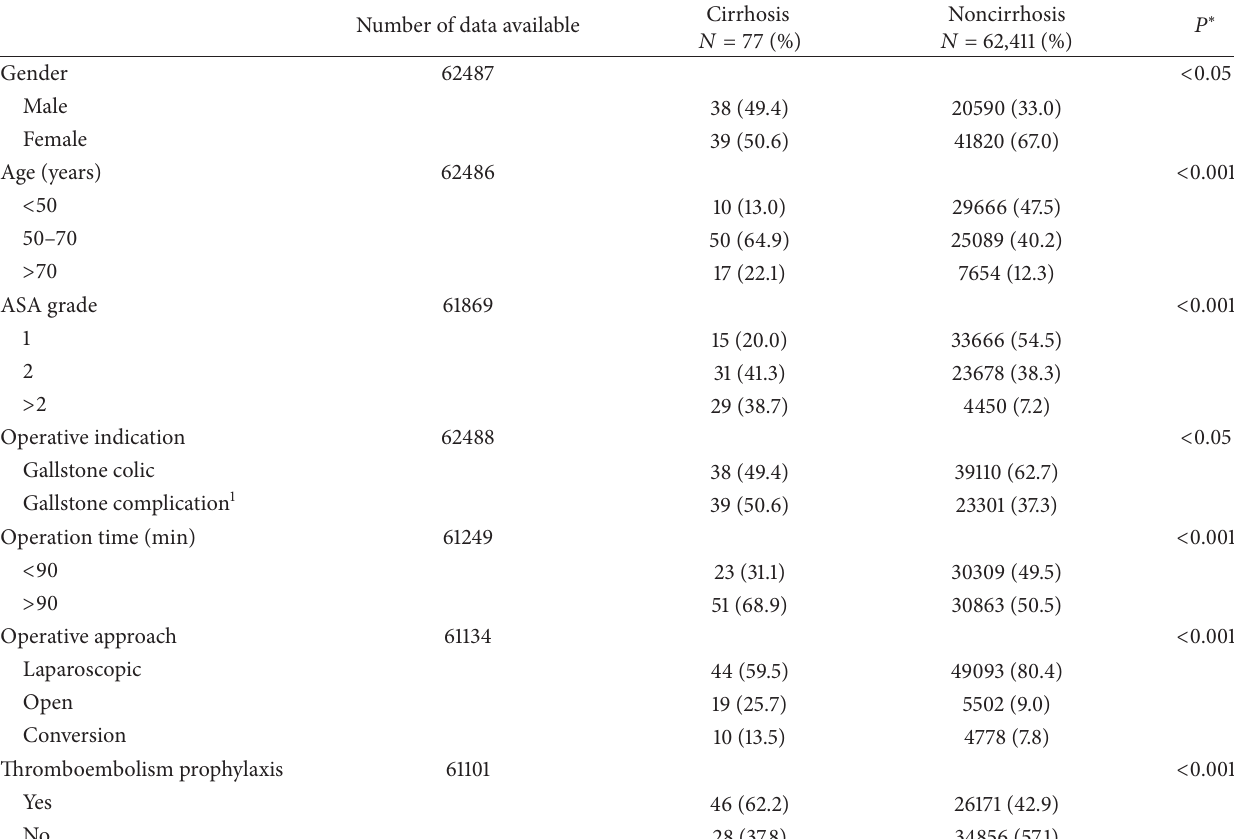
Table 1: Baseline